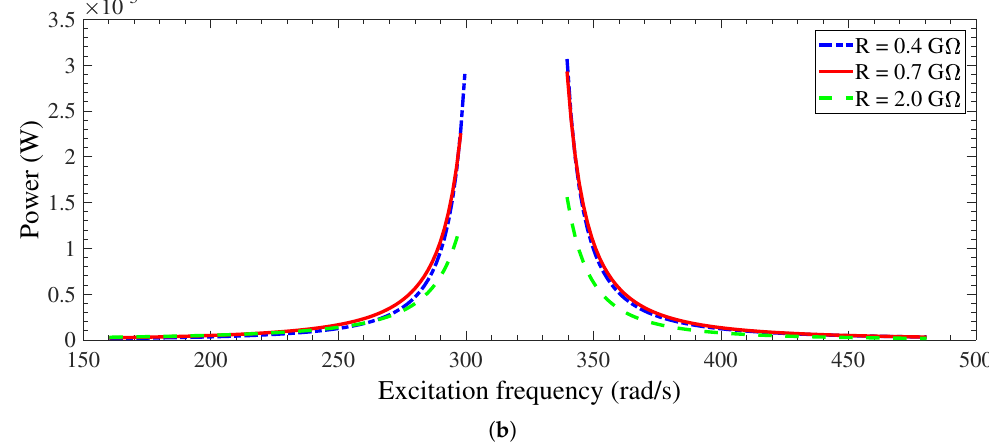
Figure 14. Frequency–response curves in terms of ( a ) displacement and ( b ) electrical harvested power for V et = 400 V and F = 5 m/s 2 .